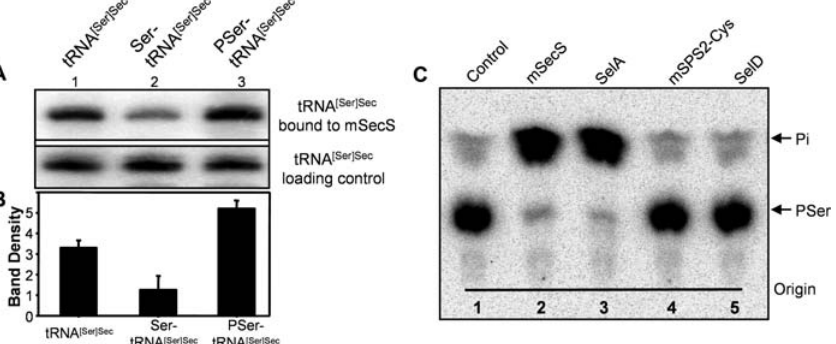
Figure 3. Binding of tRNA [Ser]Sec to mSecS-Cys and Dephosphorylation of O -Phosphoseryl-tRNA [Ser]Sec by mSecS-Cys (A) Relative efficiencies of tRNA [Ser]Sec , seryl-tRNA [Ser]Sec , and O- phosphoseryl-tRNA [Ser]Sec binding to mSecS are shown. Cloning of mSecS-Cys, its expression and purification, binding assays, and Northern analysis are detailed in Materials and Methods. The upper panel shows the binding of each form of tRNA [Ser]Sec to mSecS-Cys. The lower panel shows the amount of each tRNA [Ser]Sec used in the binding reaction which was assessed by Northern blot analysis of 2 l l of each binding reaction solution designated as tRNA loading control. (B) Amounts of each tRNA [Ser]Sec form bound to mSecS in (A) above were quantified by measuring the band densities of each form bound to mSecS relative to those of the corresponding densities of the amount of each form added to the assay using ImageQuant Version 5.2 (Molecular Dynamics). The error bars were derived from four separate binding assays. The p -value in each case is , 0.01. (C) 32 P-labeled O -phosphoseryl-tRNA [Ser]Sec was added to a reaction mixture containing either mSecS, SelA, mSPS2-Cys, or SelD, and the reaction was incubated, the aminoacyl-tRNA [Ser]Sec was deacylated, and the deacylated products were chromatographed as given in Materials and Methods. Lane 1 contains 32 P-labeled O -phosphoserine, and the other lanes contain the components shown.